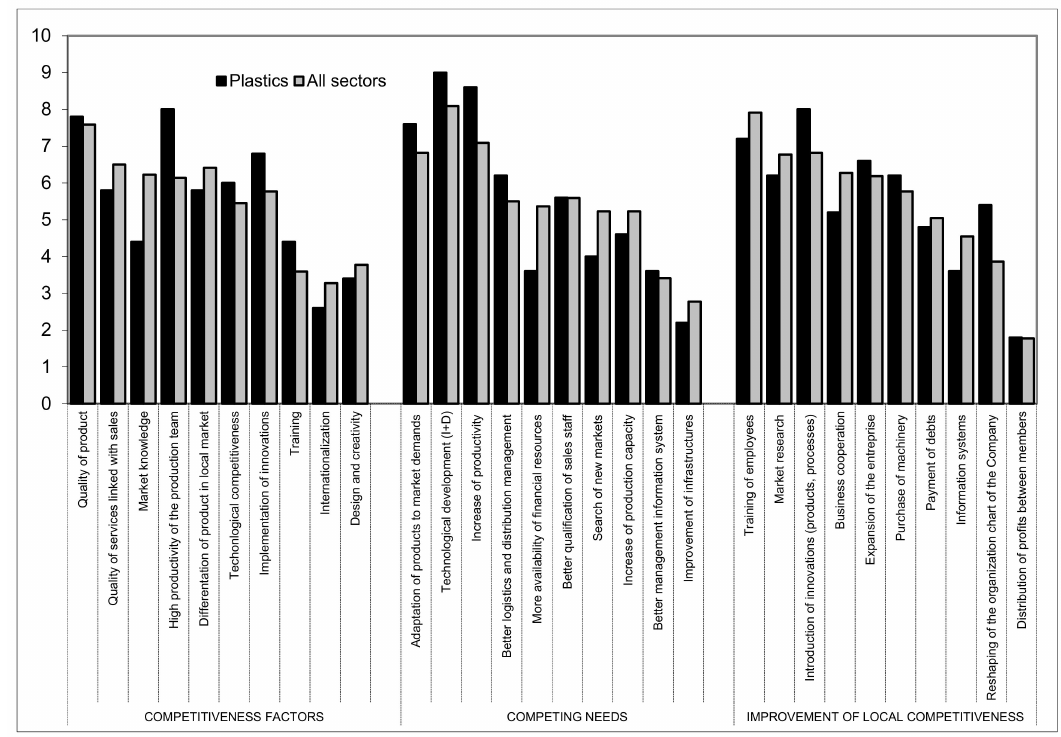
Figure 7. Issues related to competitiveness of the plastics sector in relation with other subsectors. Source—Own compilation based on data from Delphi analysis and